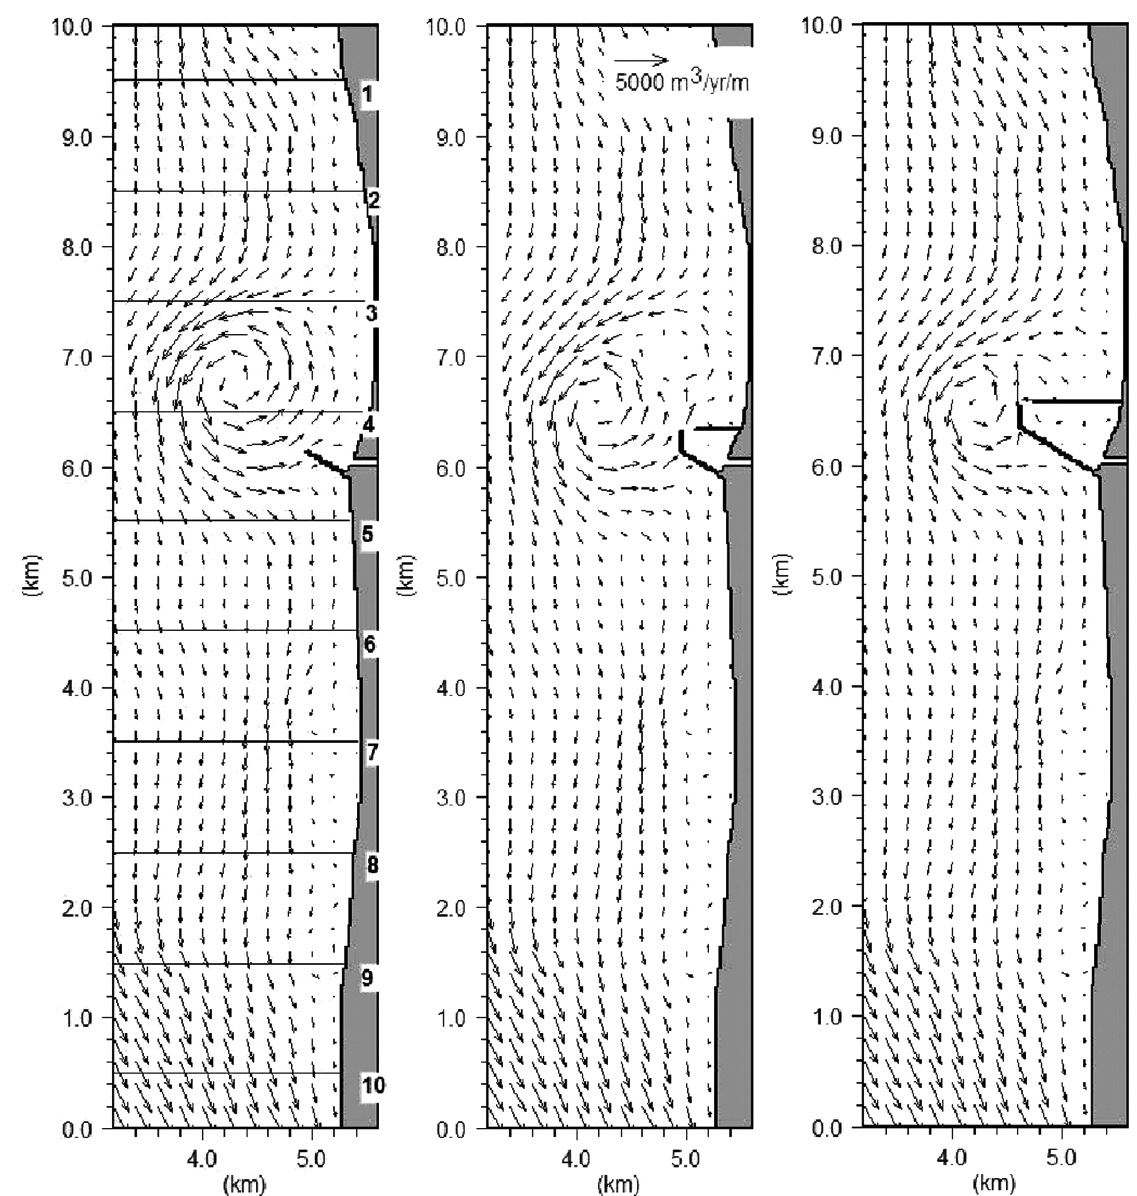
Fig. 8. Distribution of unit discharge of sediment transport (m³/year/m) blowing the wind of W direction of 20 m/s: “0” (a), “1” (b) and “2” (c) alternatives (calculation of sediment discharge was done for cross-sections from 10 to